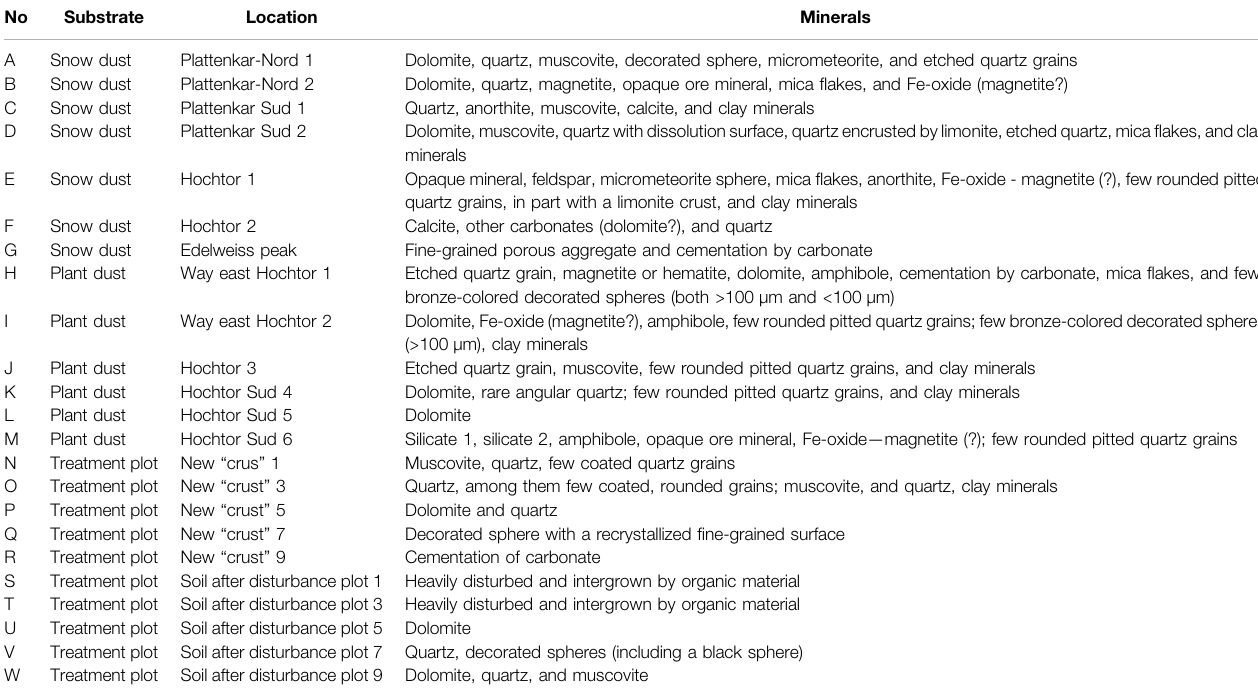
TABLE 1| Mineralogical compositionofthedust samplesat theHochtor, structured bythesubstrate. Amore detailed description oftypescanbe foundinthetext. Minerals that could not be clearly identi fi ed, were question-marked.